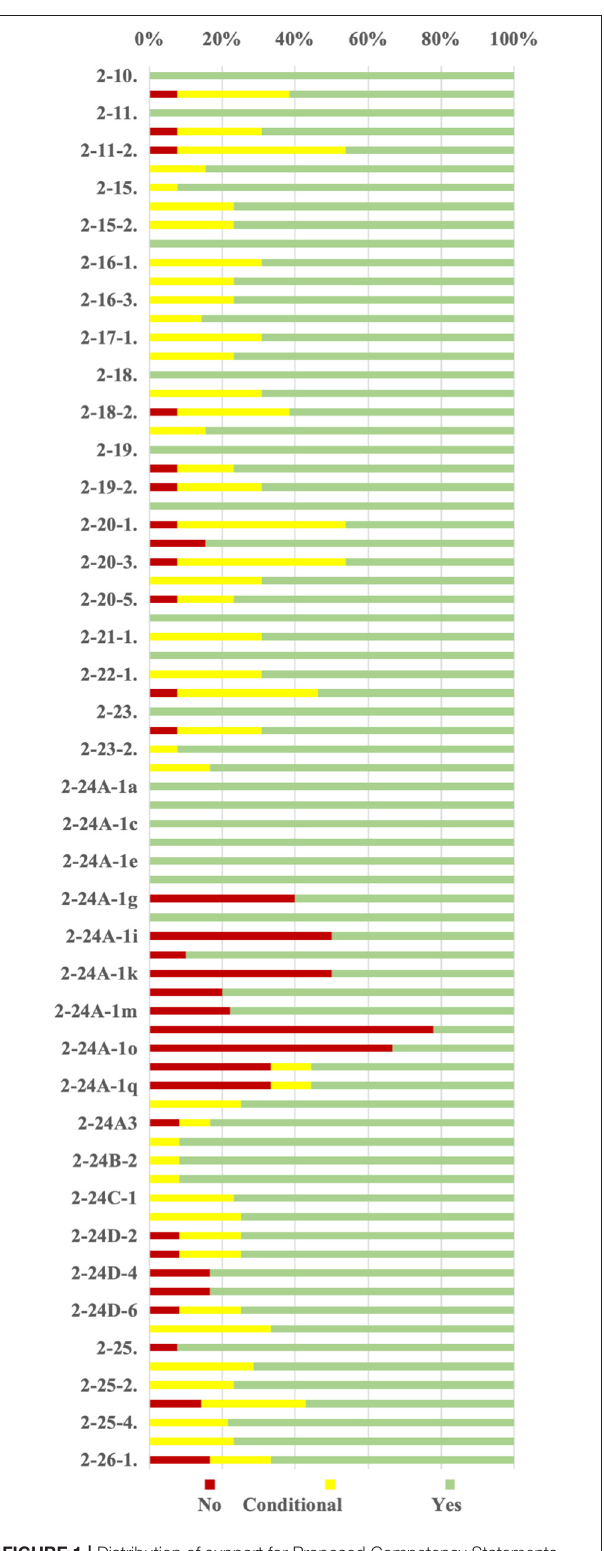
FIGURE 1 | Distribution of support for Proposed Competency Statements (PCS) for OP-PCP related to CODA Predoctoral Standards 2–10 to 2–26 [–separate